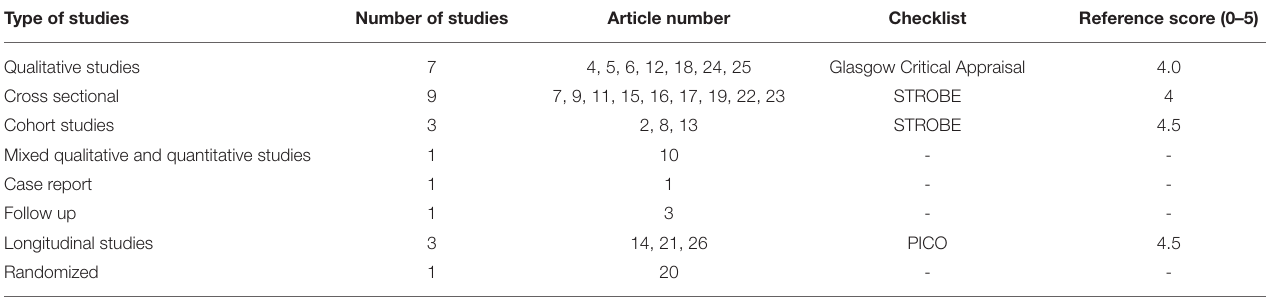
TABLE 2 | Quality assessment for eligible studies included in data